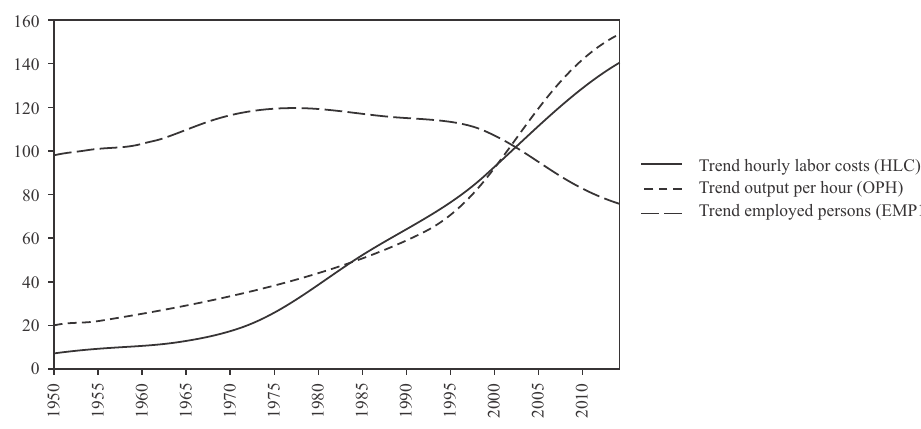
Fig.1a. The great decoupling in the U.S.